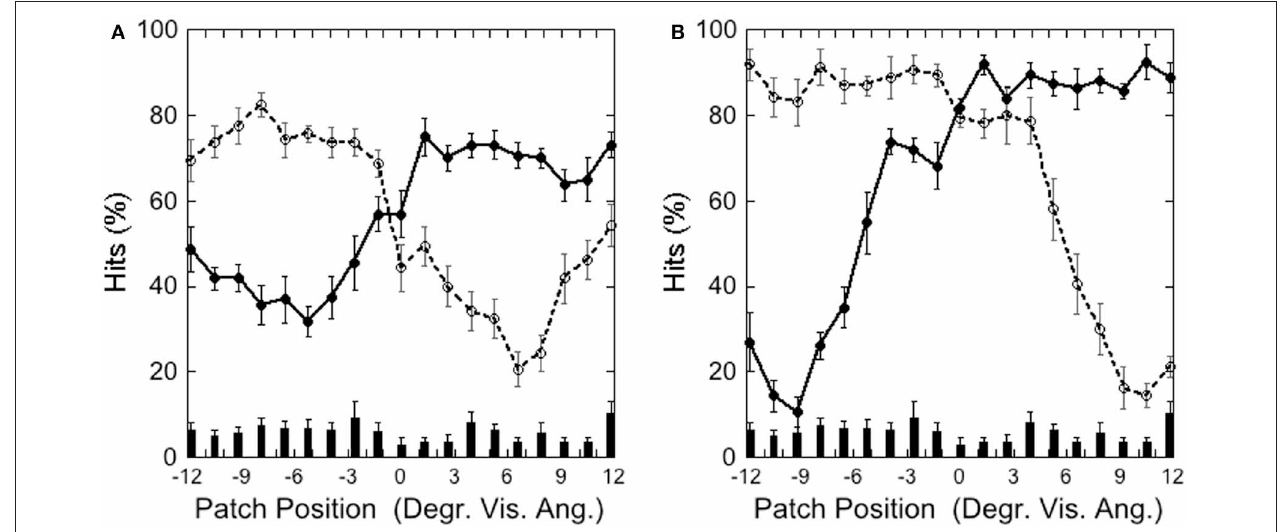
and unfilled circles show hits on the right-side target. The columns on the bottom depict false alarms as a function of patch position. Black bars depict standard